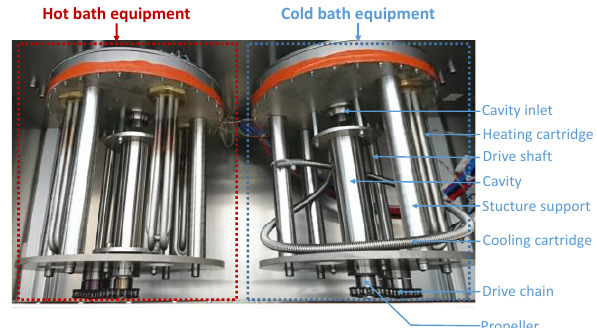
Fig. 5 Picture of the two bath-systems.